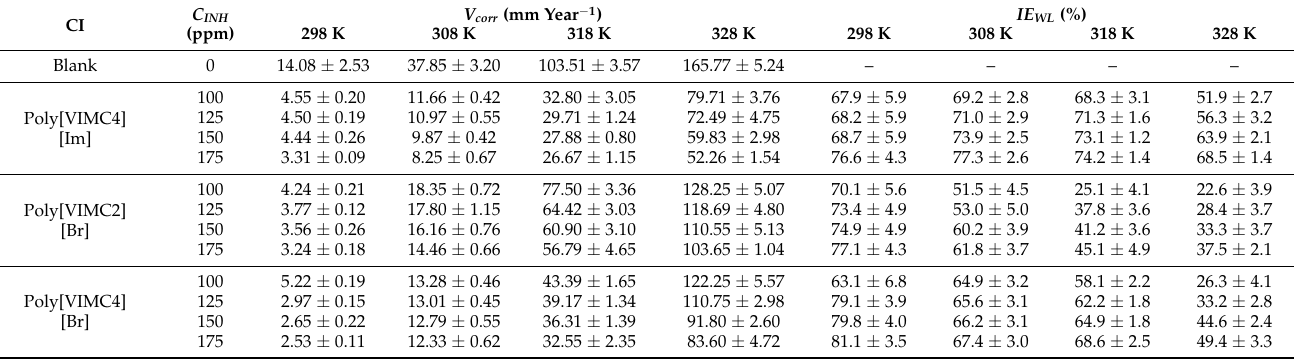
Table 2. V corr of API 5L X60 steel in 1 M H 2 SO 4 with and without CIs by weight loss.